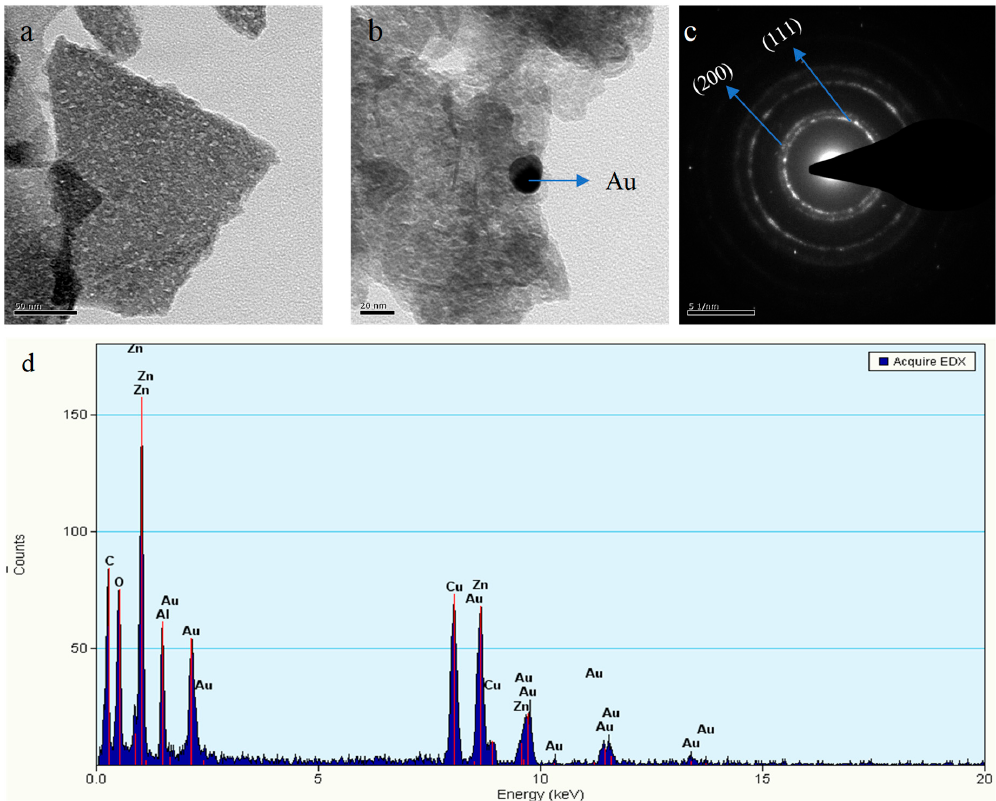
Figure 6. ( a ) TEM analysis of ZnO sample and ( b ) Au–ZnO sample, ( c ) SAED pattern for Au–ZnO sample and ( d ) Elemental analysis of Au–ZnO sample.